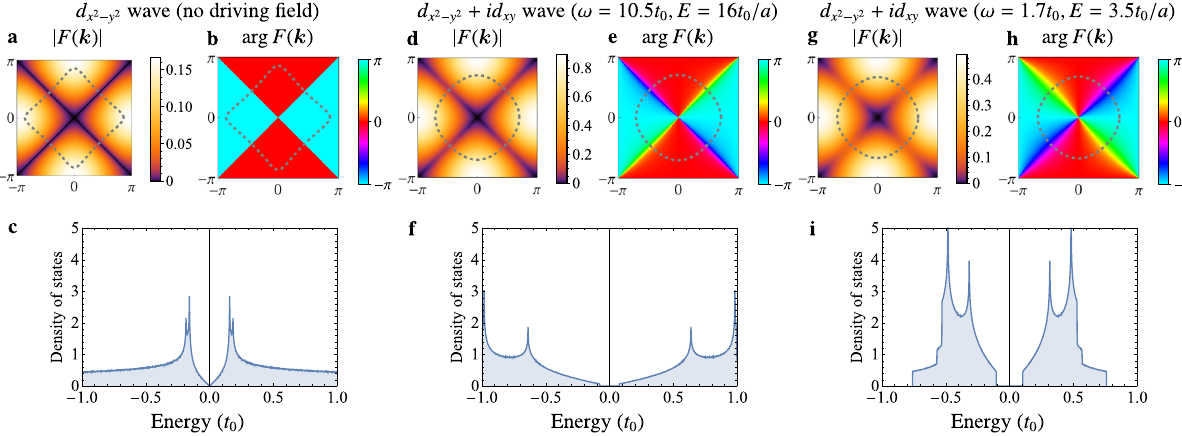
Fig. 4 Gap functions. a – c d x 2 (cid:3) y 2 -wave superconductivity in the absence of driving fi eld. d – i d x 2 (cid:3) y 2 þ id xy -wave superconductivity in the circularly-polarised laser. The driving frequency ω and the fi eld amplitude E are chosen as ω = 10.5 t 0 = 0.88 U , E = 16 t 0 / a ( d – f ), or ω = 1.7 t 0 = 0.14 U , E = 3.5 t 0 / a ( g – i ). a , d , g Colour-coded absolute values of the gap function, ∣ F ( k ) ∣ ; b , e , h phases, arg F ð k Þ . The dashed lines represent the Fermi surface at the critical temperature T = T c . c , f , i Density of states against energy in units of the bare hopping amplitude t 0 . We take a parameter set: the bare second-neighbour hopping t 0 ¼ (cid:3) 0 : 2 t 0 , the onsite interaction U = 12 t 0 , and a doping level δ = 0